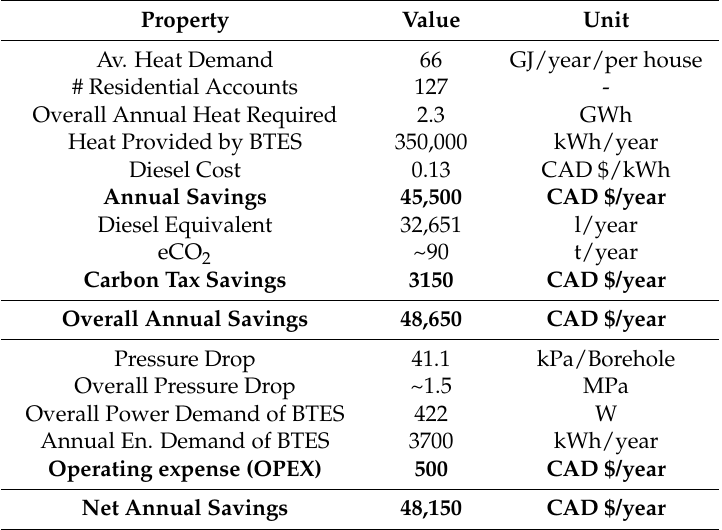
Figure 7. Ground thermal behavior showing three years of heat injection and seasonal cyclic thermal storage and recovery process. Table 5. Annual heat demand of Kwadacha and system sizing